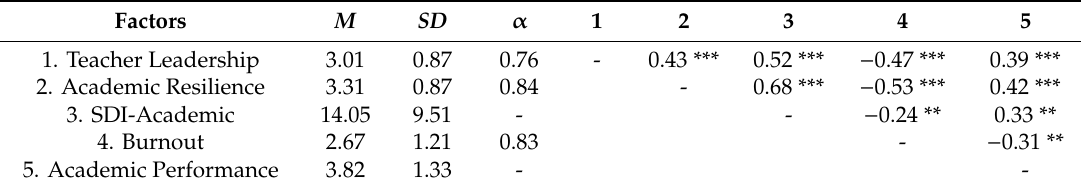
Table 3. Descriptive statistical analysis and reliability